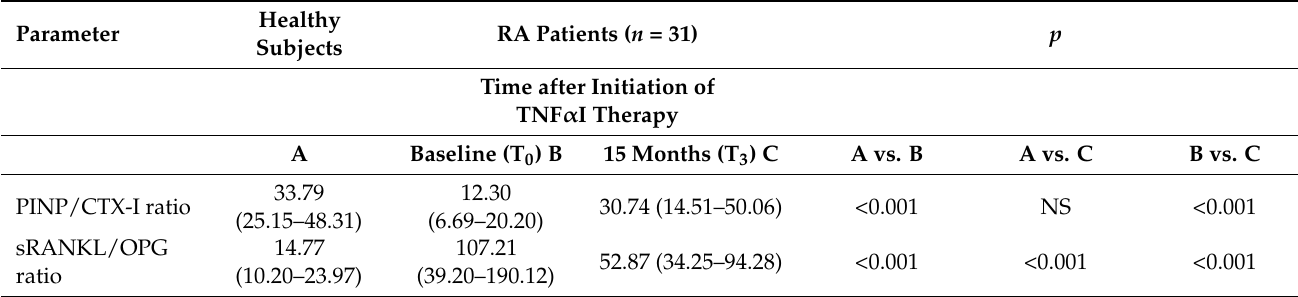
Table 4. The ratios of PINP to CTX-I and sRANKL to OPG in women with rheumatoid arthritis at baseline and after 15 months of anti-TNF- α therapy, and in healthy